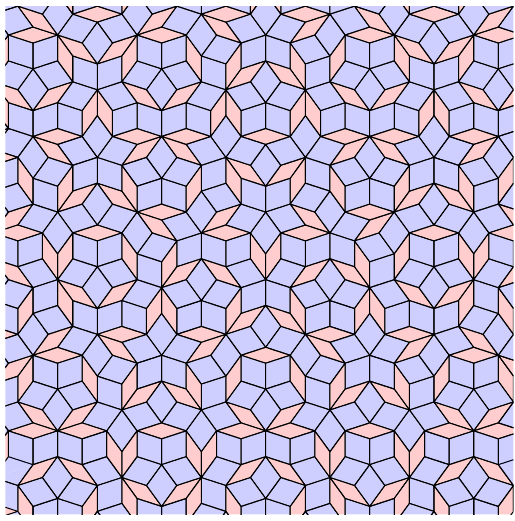
FIG. 1. A finite section of the Penrose tiling constructed of two rhombuses (colored red and blue